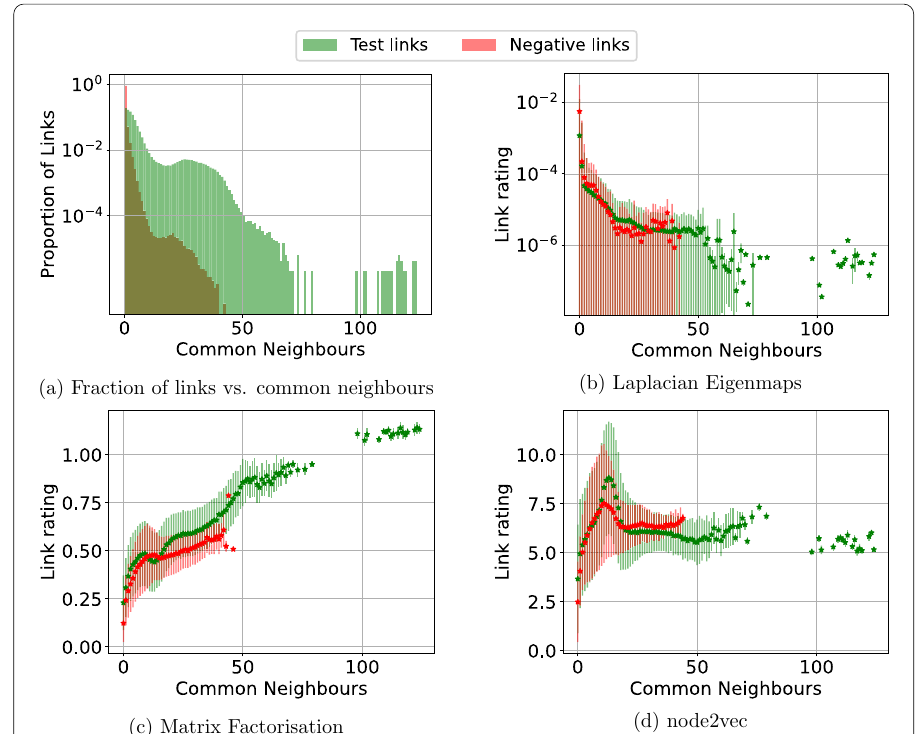
Fig. 4 a Fraction of links of the Hamsterster network (rewired C = 0.30 ) that share a given number of neighbours. Average rating of negative and test links with a given number of common neighbours derived by b Laplacian Eigenmaps, c Matrix Factorisation, and d